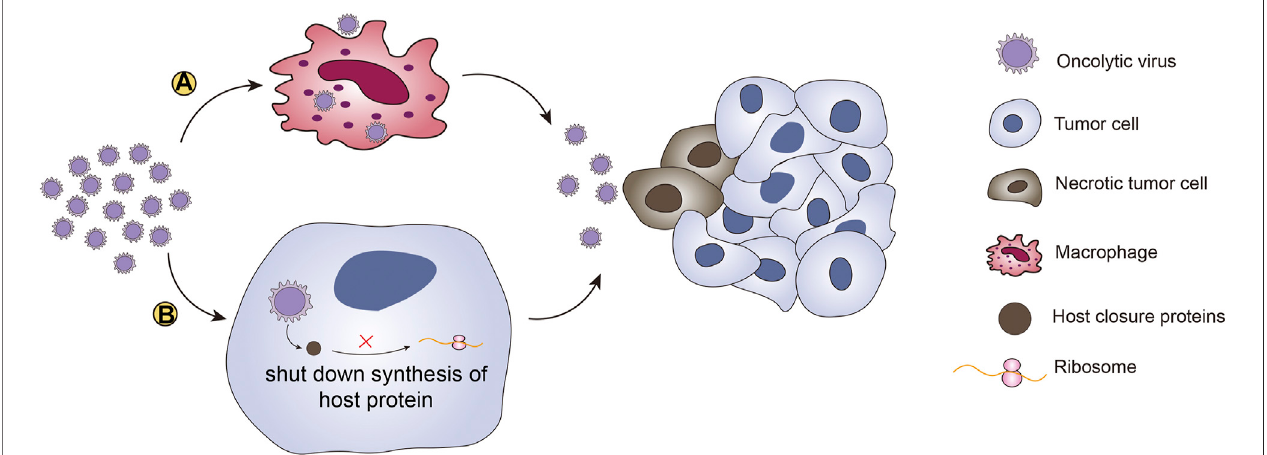
FIGURE 3 | Therapeutic barriers of oncolytic viruses. There are two main barriers to the induction of antitumor effects by oncolytic viruses. (A) Macrophages can directlycapture virusesinorgans suchastheliver.Macrophagesreduce thevirustiterand theantitumor effectsthroughphagocytosis. (B) Theotherbarrierforoncolytic viruses is blockade of host protein synthesis. Oncolytic viruses encode host closure proteins that can shut down synthesis of host proteins, destroy pre-existing polysomes, degrade host mRNAs, and interfere with the production of viral offspring. This “ host shutoff ” is not conducive to virus replication or the expansion of neoantigen-reactive